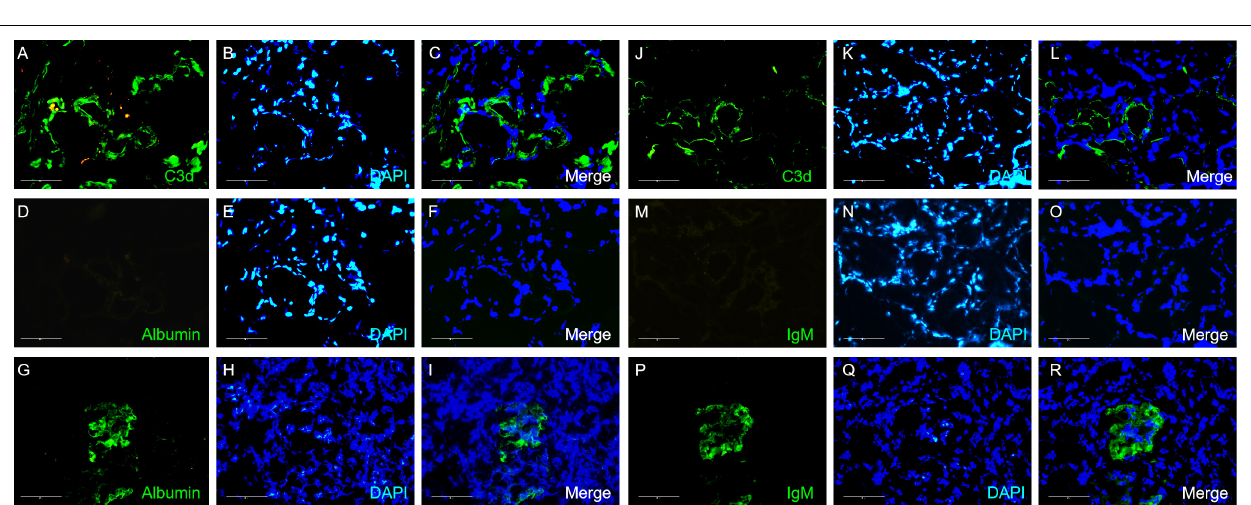
FIGURE 3 | Immunohistochemical staining for C3d deposition in arterionephrosclerosis. C3d was deposited on arterioles with different intensities and patterns (black arrows) ( A–C , 200 × ; D–H , 400 × ). (I) Showed the correlation between the intensity of C3d deposition and the ratio of the inner/outer diameter of arterioles.